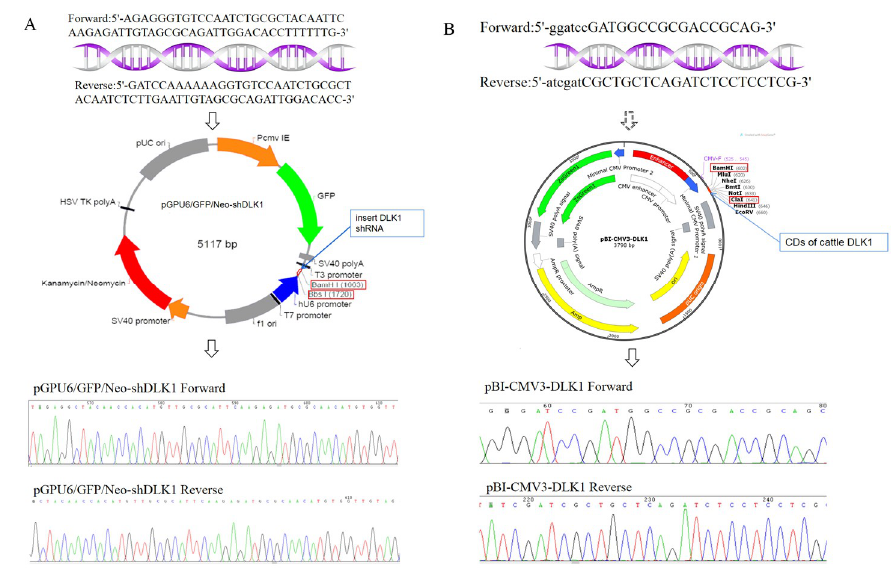
Figure 2. The DLK1 gene interference vectors and overexpression vectors. Primer sequence of the RNA interference target sequence and interference vectors (pGPU6‐shDLK1) ( A ), the primer sequence of coding sequences and overexpression vectors (pBI‐CMV3‐DLK1) ( B ).